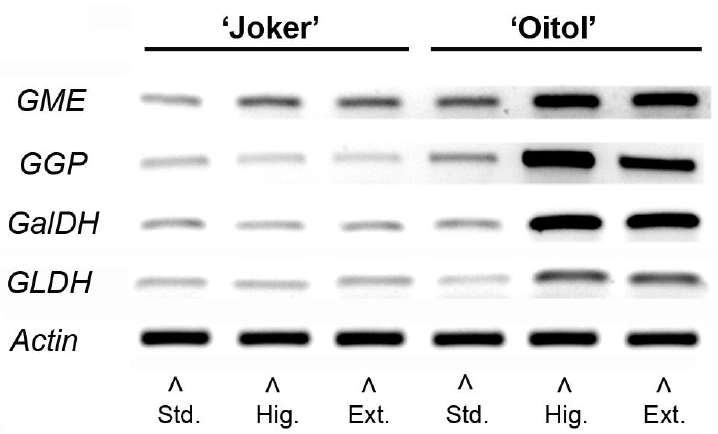
Figure 4. Semiquantitative RT-PCR expression analysis of Smirnoff–Wheeler AsA biosynthetic path- way genes in the leaves of two F1 cucumber hybrid lines treated with different nitrate